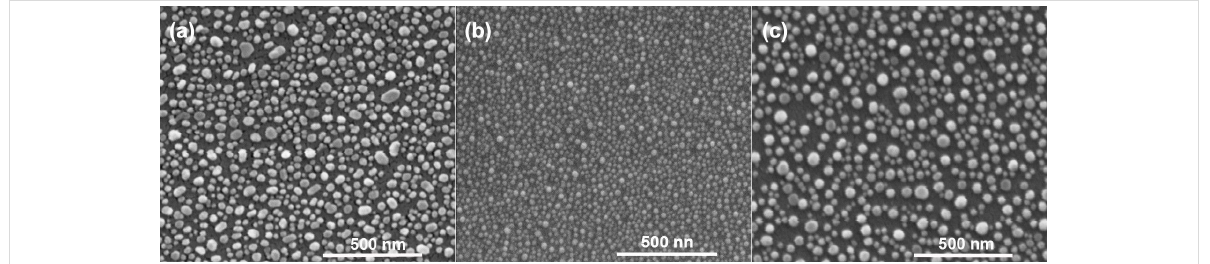
Figure 3: SEM images of 2.8 nm Au films on a Si(111) substrate annealed at a) 450 °C, b) 550 °C, c) 600 °C for 15